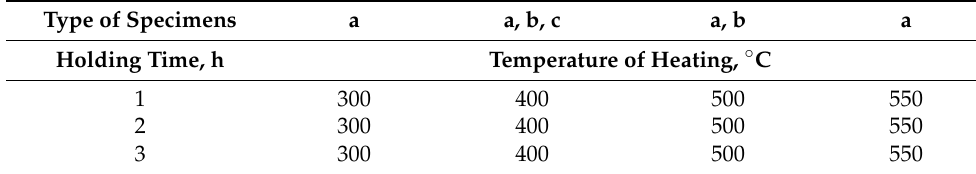
Table 2. HT modes for samples of the Ni – Al system.